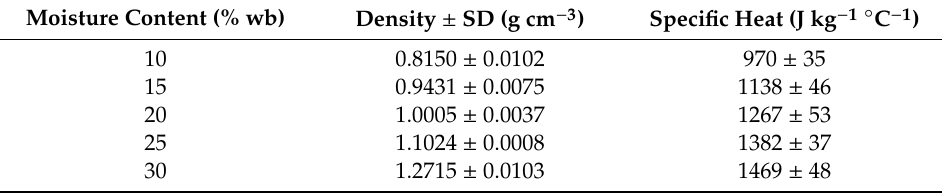
Table 2. The densities and specific heat of pecan kernel at five moisture